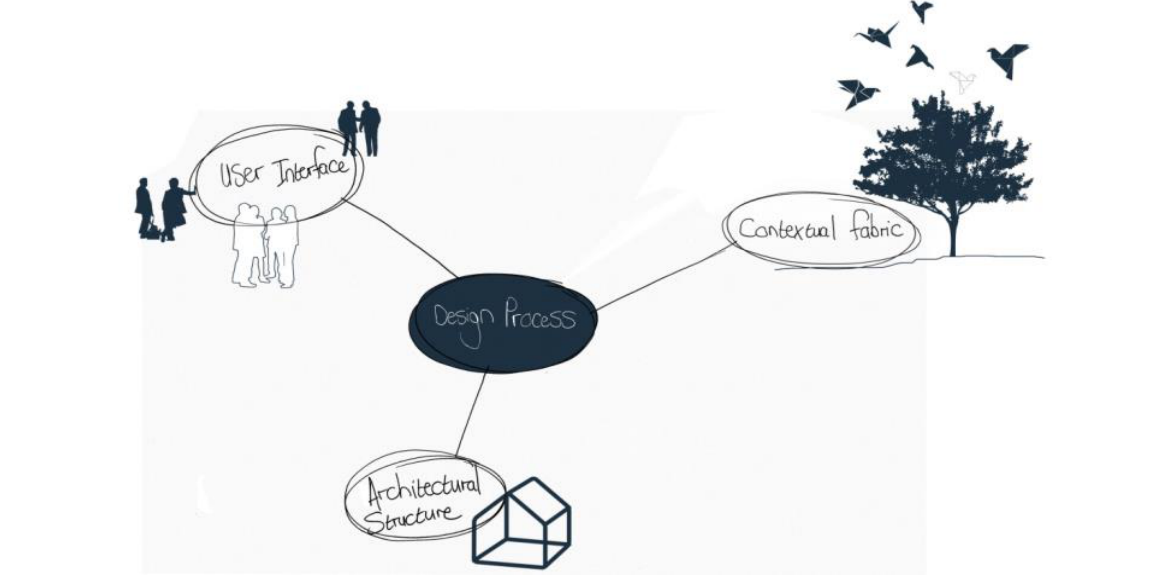
Figure 9. Interdependent ecosystem influencing the design process. (Author,